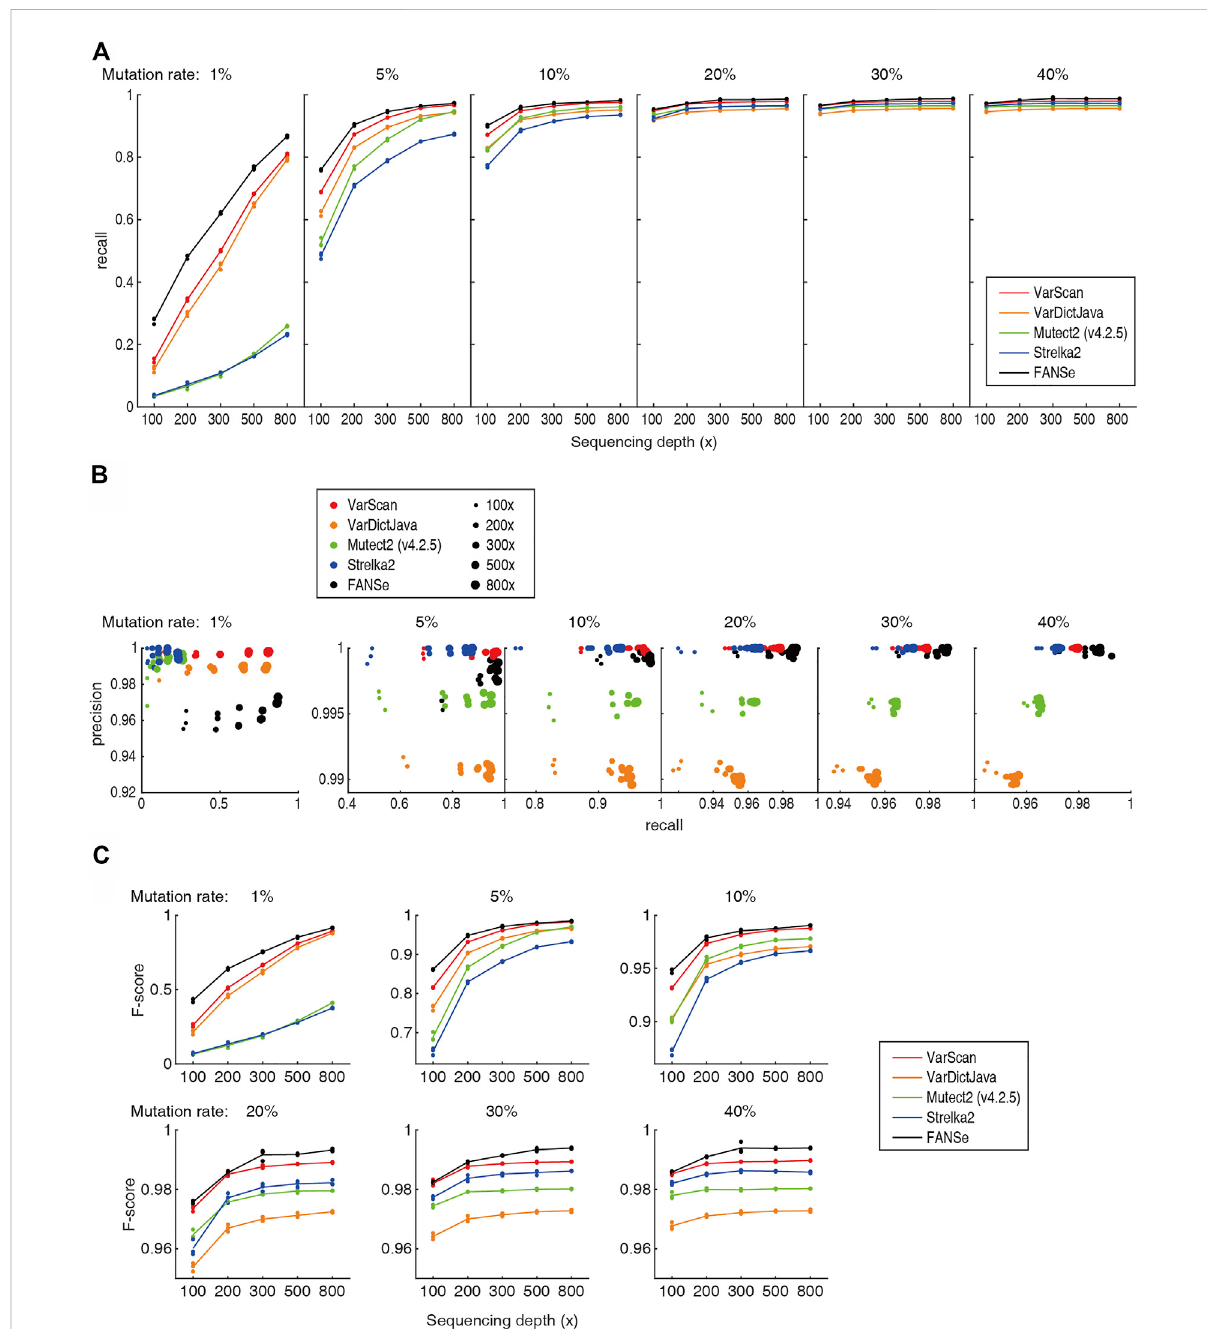
FIGURE 3 Accuracy of the 5 pipelines. All detailed numbers are listed in Supplementary Table S1. (A) The recall rate of the 5 pipelines at different sequencingdepthsandmutationrates.Foreachmutationrateandsequencingdepth, thedatapointsforthe3datasetswereall